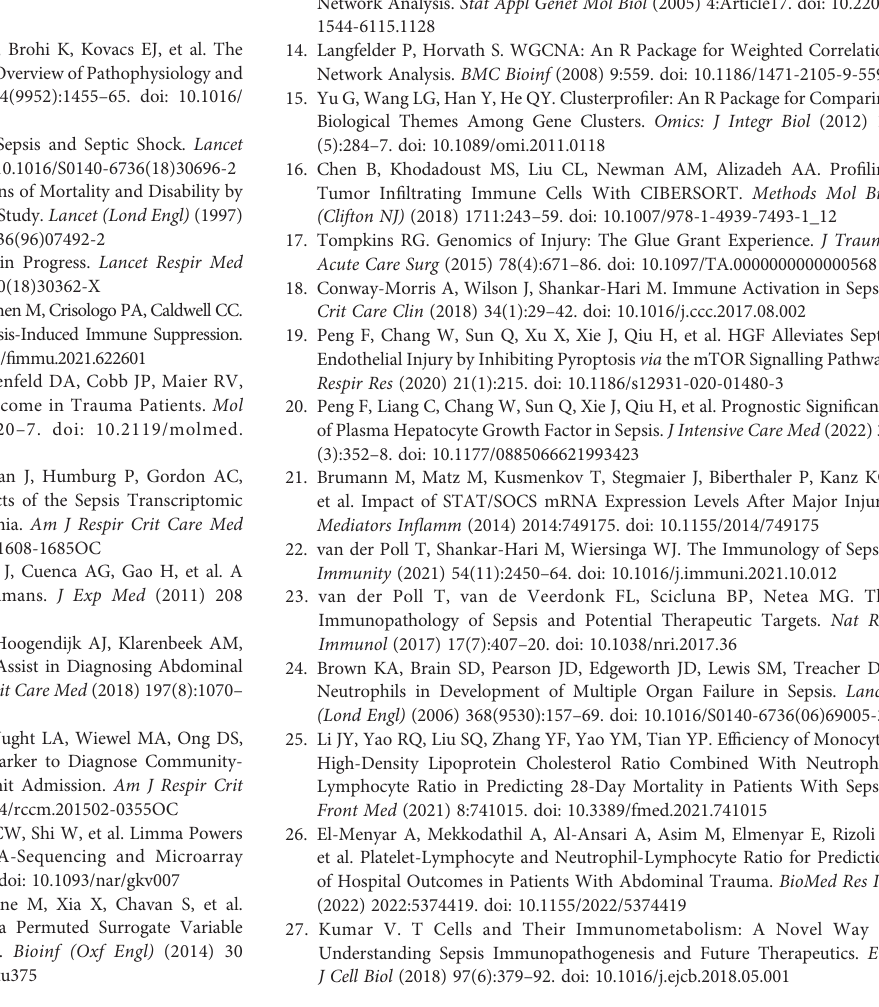
Supplementary Figure 1 | Differential expression analysis of genes associated with trauma and sepsis. (A) The distribution of gene expression before and after eliminating the batch effect. (B) Volcano plot of DEGs in trauma and the number of downregulated and upregulated DEGs. (C) Volcano plot of DEGs in sepsis and the